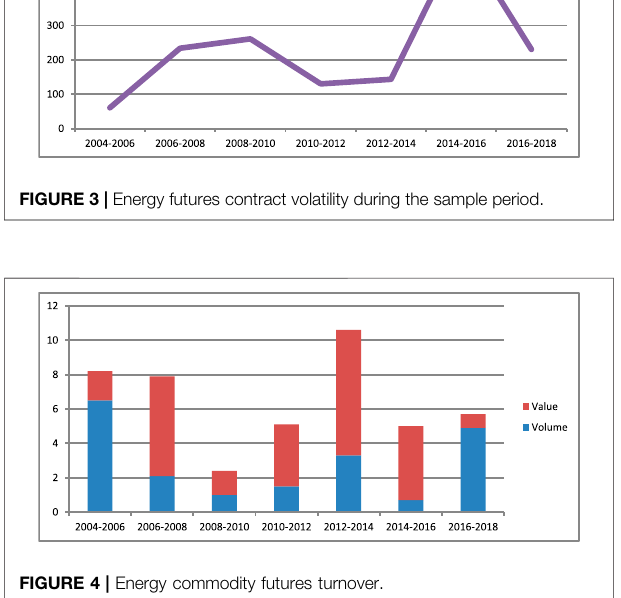
FIGURE 4 | Energy commodity futures